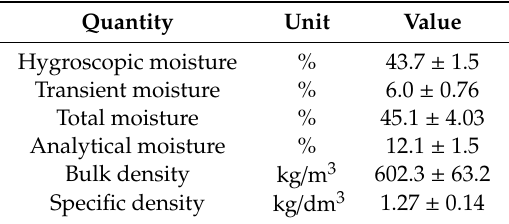
Table 1. Physical properties of PETWW.